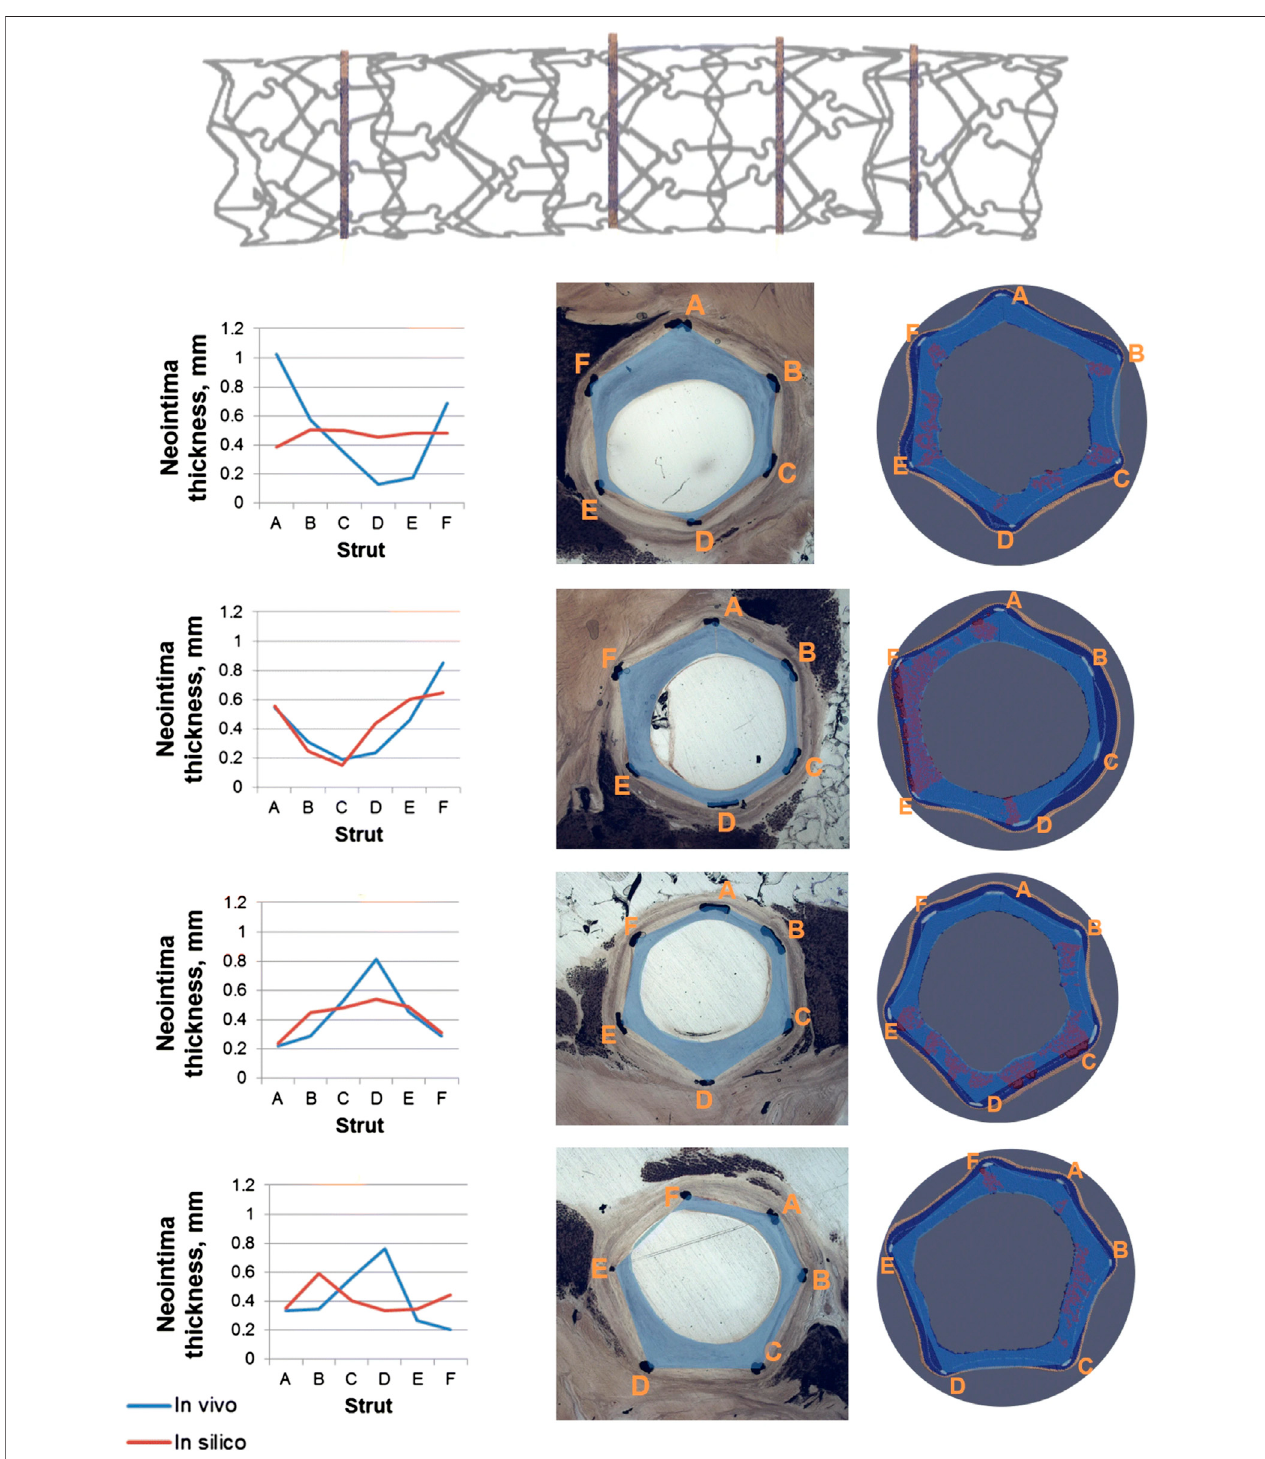
FIGURE 7 | Results of the multiscale agent-based modeling framework of in-stent restenosis of Zun et al. (2019). At the top, the stent geometry is shown, with indicationsonthepositionofthefouranalyzed cross-sections.Atthebottom, theresultsat 28 daysareshownforthefour cross-sections.Foreach cross-section:1)on theleft,aquantitativecomparisonofthepredicted( in-silico )and in-vivo neointimalthicknessisprovidedforthe6strutslocations(A – F),2)inthemiddle,the in-vivo cross- section is shown and 3) on the right, the in-silico cross-section is represented, with the smooth muscle cells (SMCs) in dark blue, the internal elastic lamina (IEL) in light blue, the external elastic lamina (EEL) in beige, the extracellular matrix (ECM) in red and the stent struts in light grey. Both in the in-vivo and in-silico silico cross- sections the blue area represents the neointima estimation. Reprinted with permission from Zun et al. (2019) (http://creativecommons.org/licenses/by/4.0/).